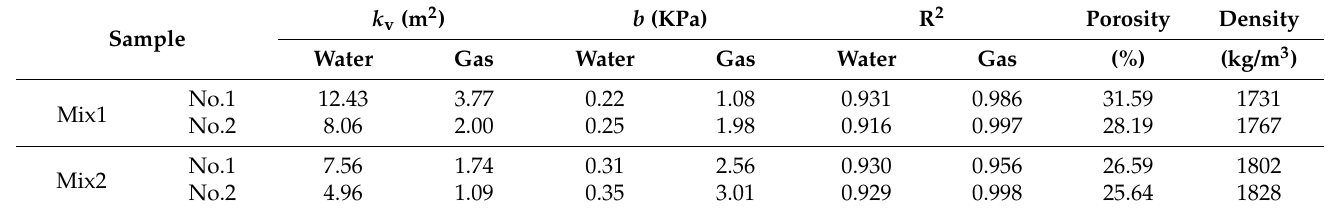
Figure 7. The measured values of the permeability of the pervious concrete samples and the reciprocals of the pressure differences. Table 2. The permeability of the pervious concrete samples and the regressed coefficients.